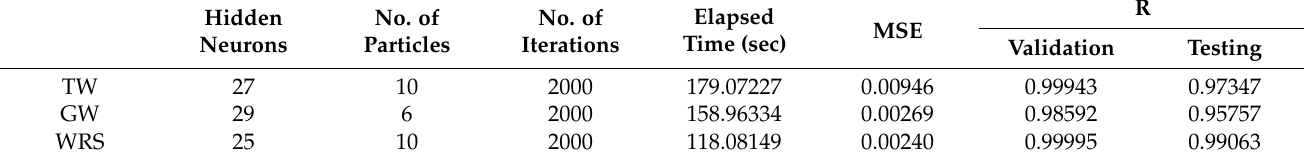
Table 11. NN-PSO simulation results for the MPI mapping of domestic water samples.